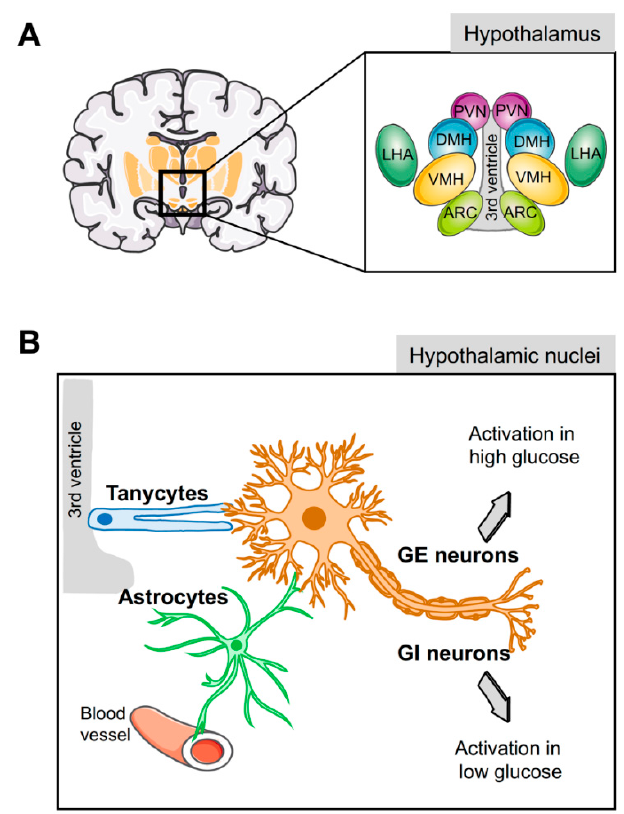
Figure 1. Glucose sensing by the hypothalamus. ( A ) Schematic representation of the different hypothalamic nuclei and their location surrounding the third ventricle. ( B ) Glucose-inhibited (GI) and glucose-excited (GE) neurons play a key role in glucose homeostasis; nevertheless, since these neurons are not located in direct contact with blood vessels or cerebrospinal fluid, sensing of circulating glucose levels is relayed through the hypothalamic glial cells (tanycytes and astrocytes). ARC, arcuate nucleus; VMH, ventromedial hypothalamic nucleus; DMH, dorsomedial hypothalamic nucleus; PVN, paraventricular nucleus; LHA, lateral hypothalamic area.